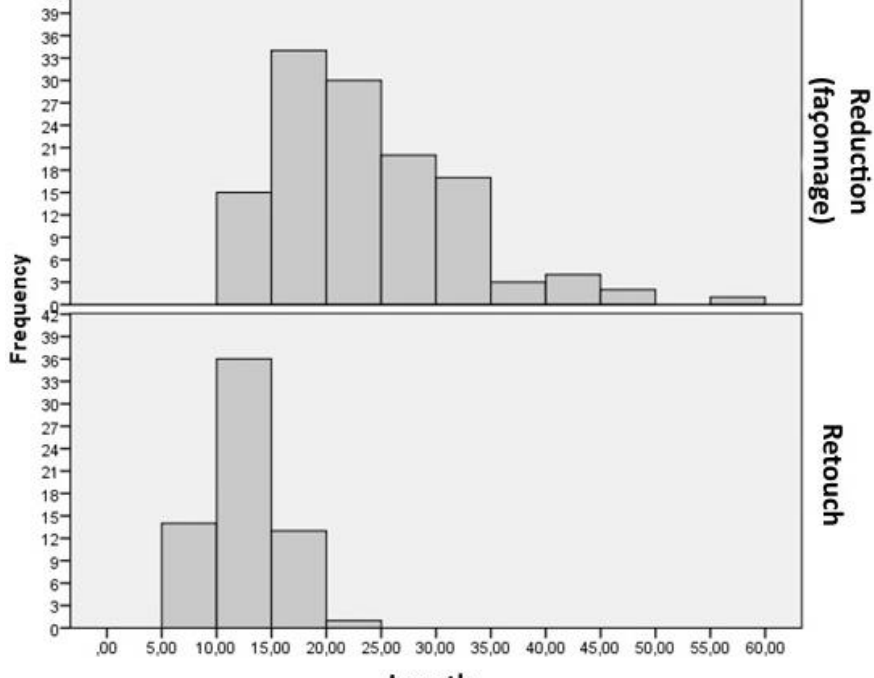
Figure 7. Reduction and retouch flake length